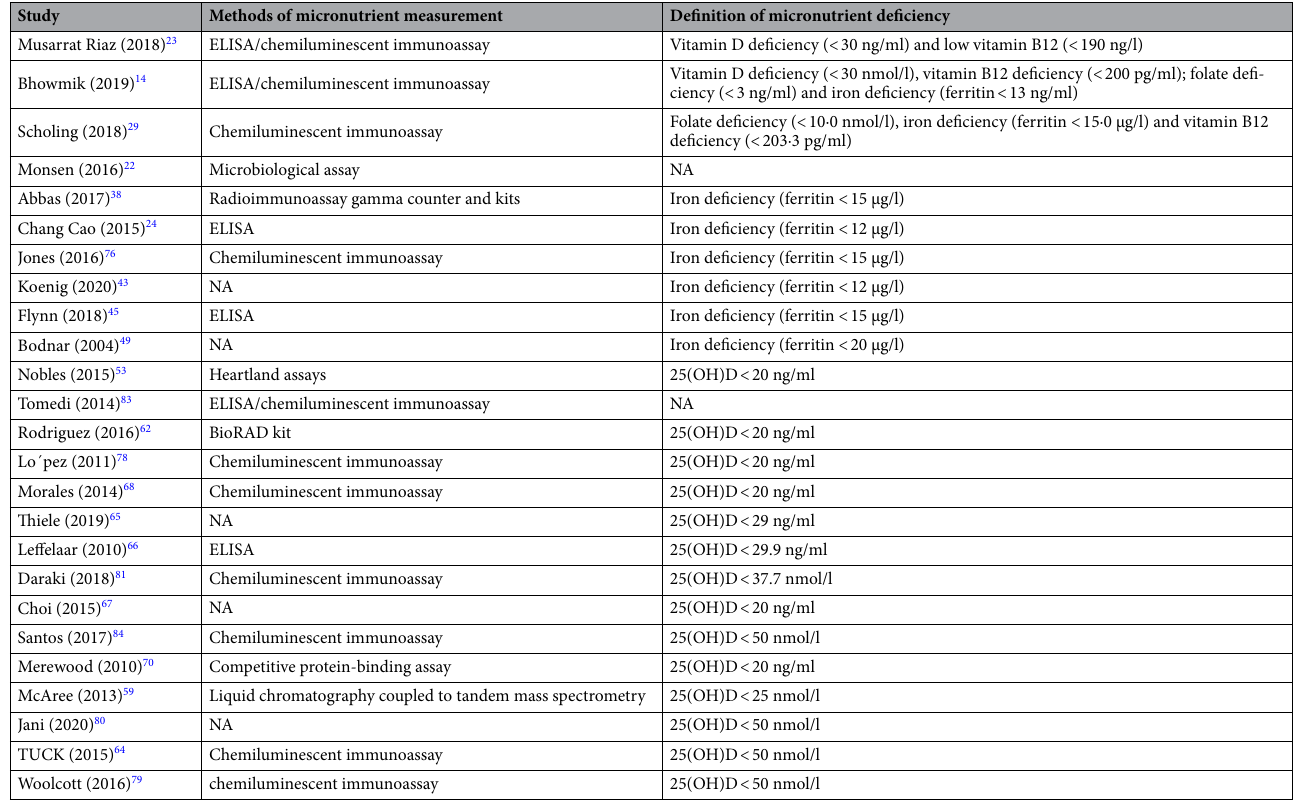
Table 2. Characteristics of studies on micronutrient deficiency. NA data not